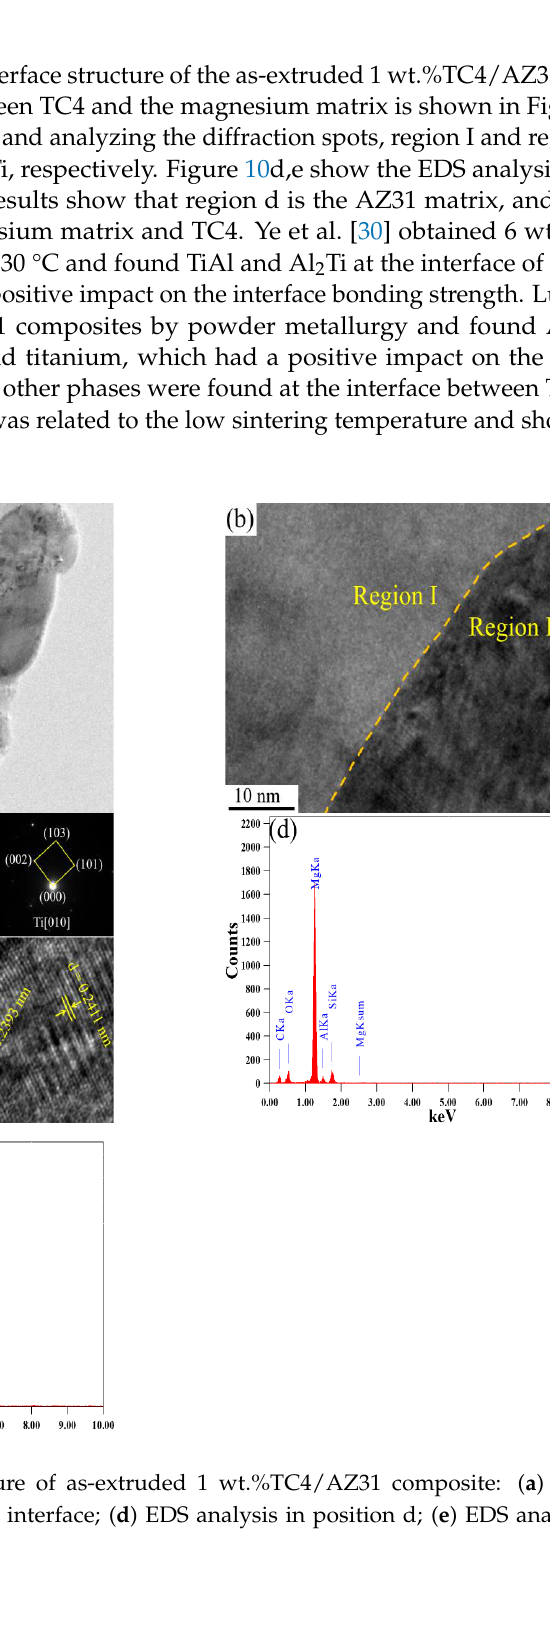
Figure 11. Stress – strain curves of as-extruded TC4/AZ31 composites in tensile tests.